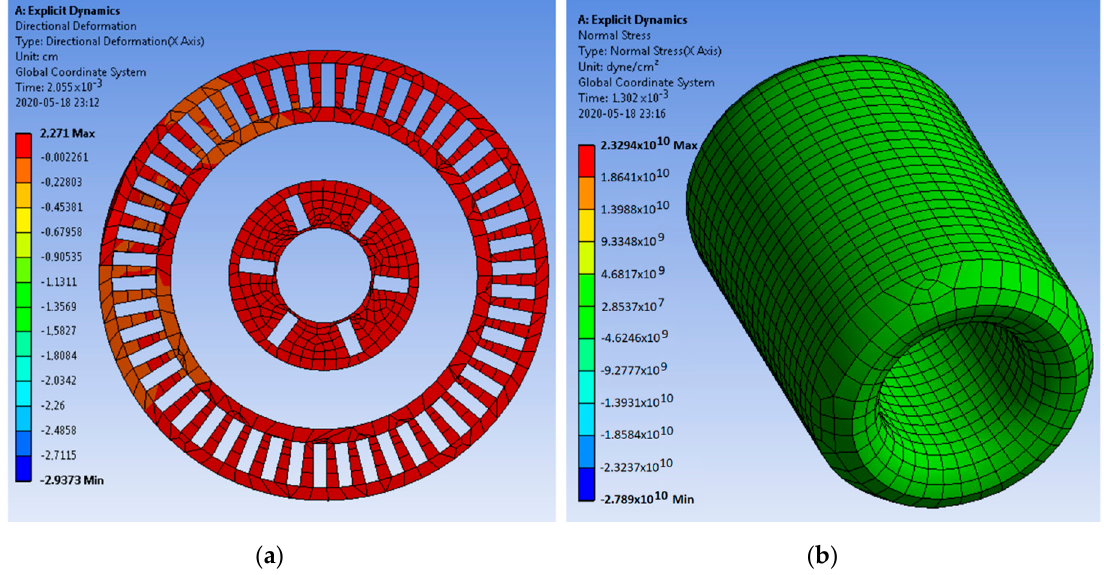
Figure 11. Crown analysis: ( a ) View of the lamella fastening crowns and ( b ) view of the movable part of the contact. Energies 2020 , 08 , x FOR PEER REVIEW